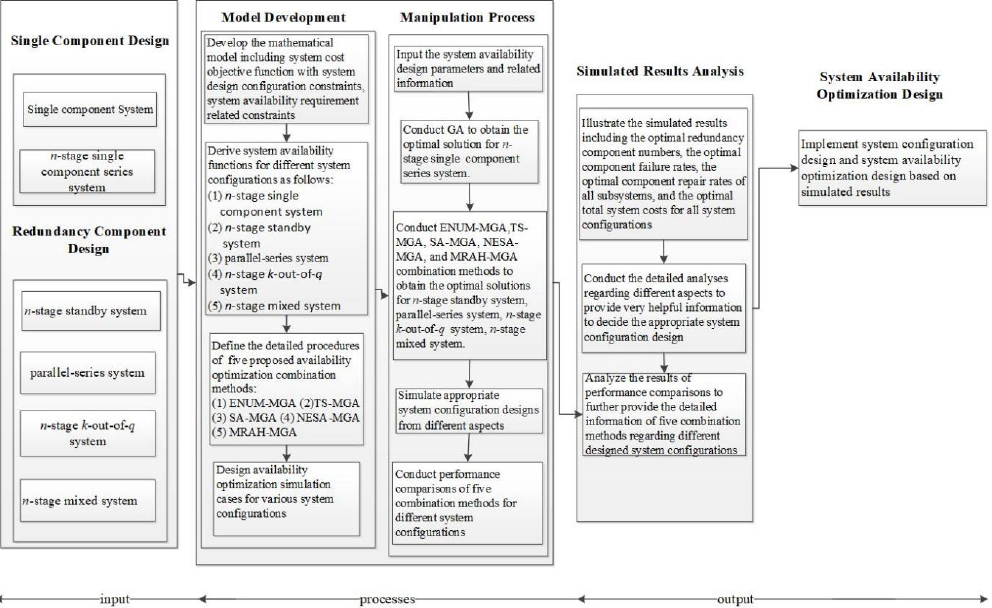
Figure 1. The procedure flow of the proposed availability optimization decision support design system.